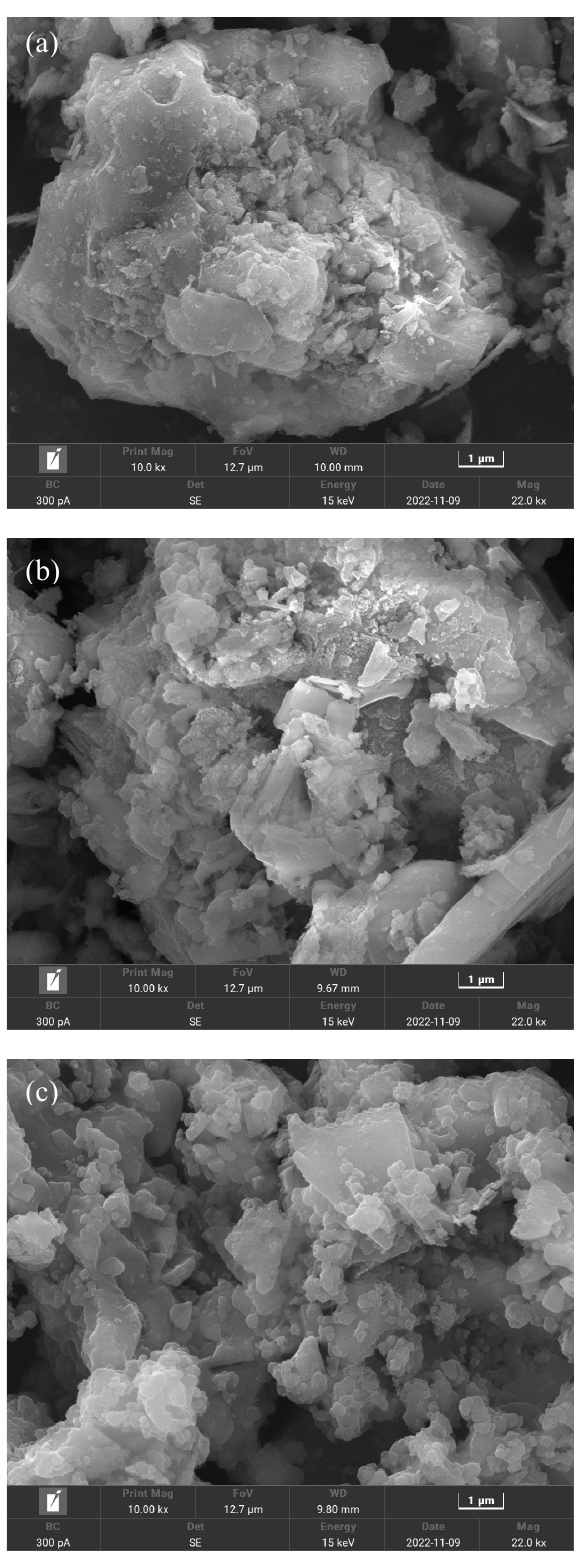
Figure 10. SEM image: ( a ) original samples; ( b ) non-enhanced acid-leaching residues; and ( c ) enhanced acid-leaching residues.